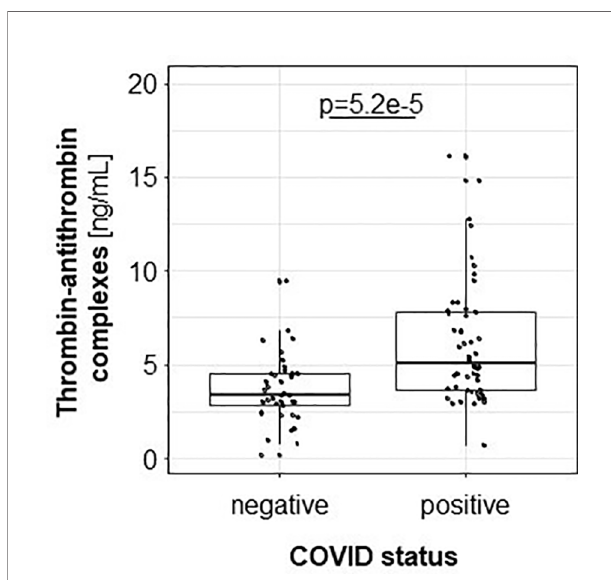
FIGURE 2 | Thrombin-antithrombin complex is higher in COV pos ( n = 50) than in COV neg ( n =